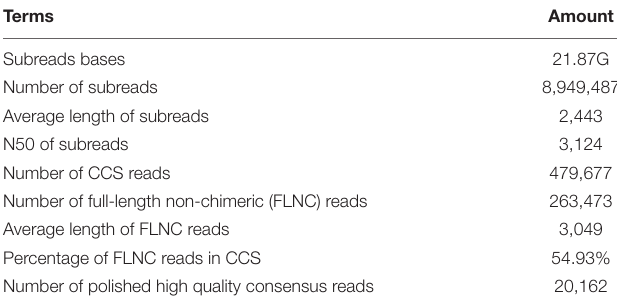
TABLE 1 | Summary of PacBio sequencing data in A. japonicus